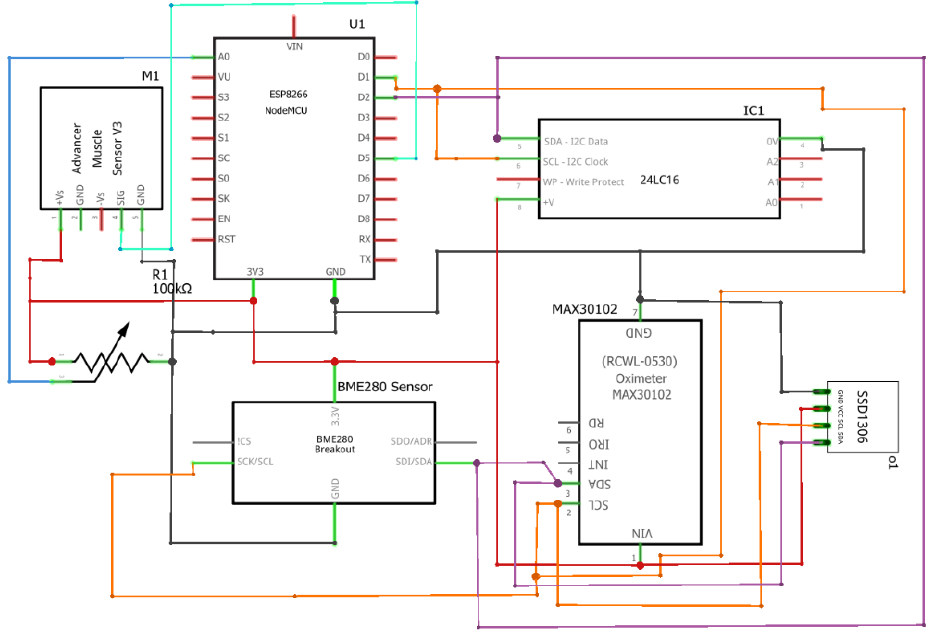
Figure 3. Circuit diagram of the